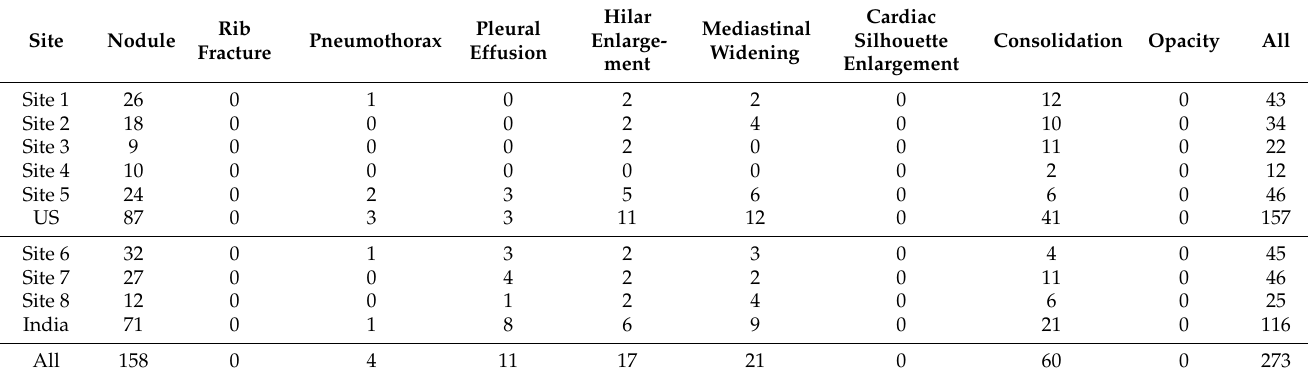
Table 2. Summary of site-wise distribution of clinically important missed findings (per radiologist ground truth) in radiology reports which were not documented in the radiology reports.